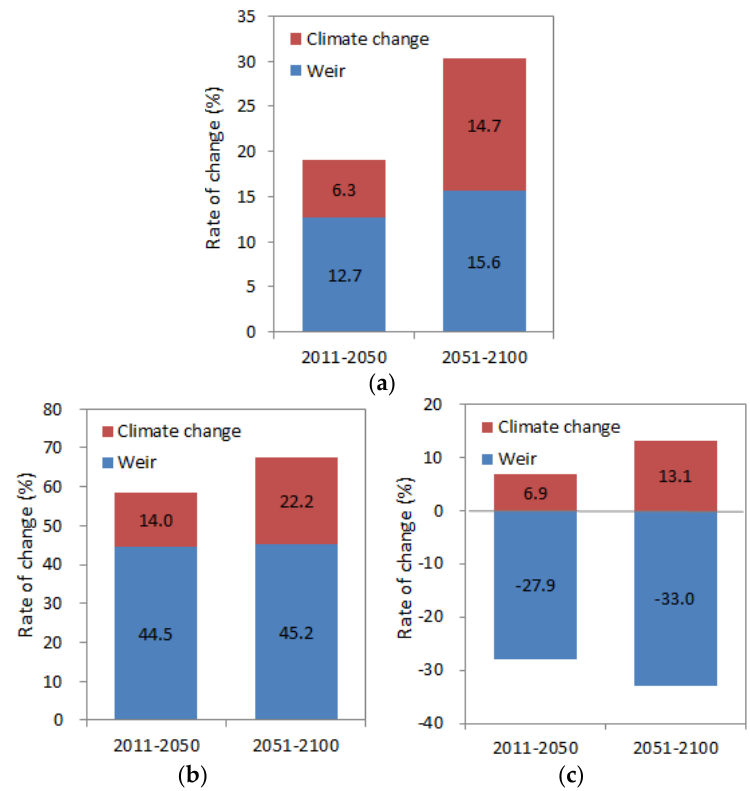
Figure 8. Impacts of climate change and weirs on future runoff characteristics of the lower Geum River. ( a ) Daily discharge (Average of January–December); ( b ) 1-day minimum; ( c ) 1-day maximum.